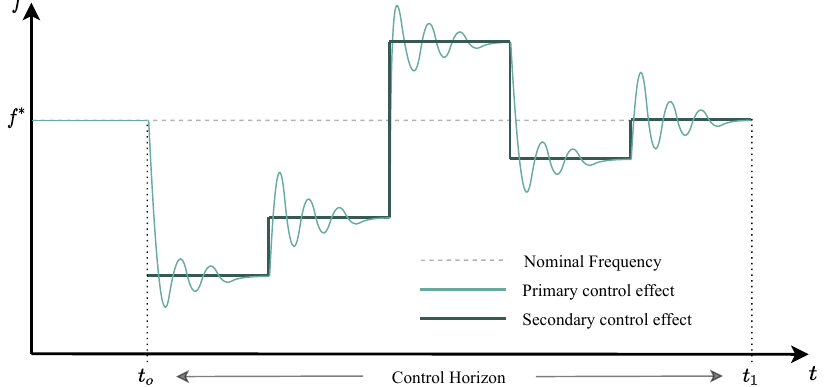
Figure 3. Receding horizon strategy for a centralized hierarchical control structure in islanded